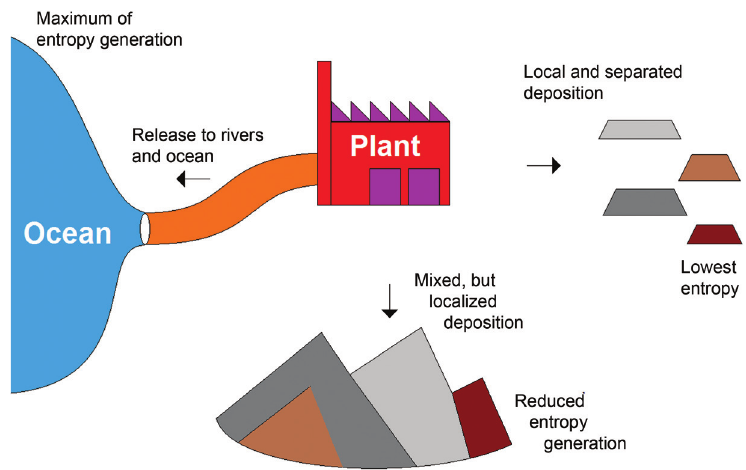
Figure 8 Substitution of waste depots by long-term entropy export